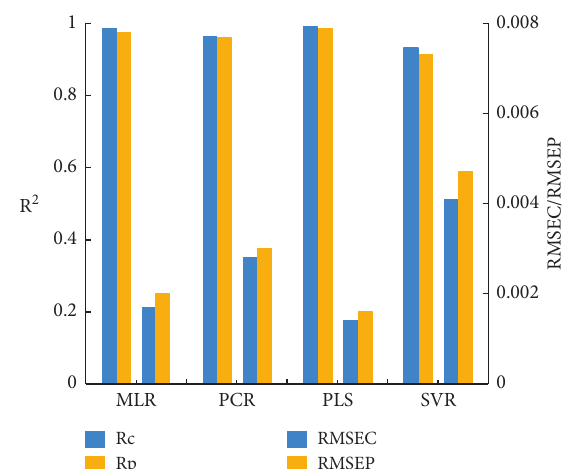
Figure 4: Prediction results of moisture content in walnut kernel using different modeling